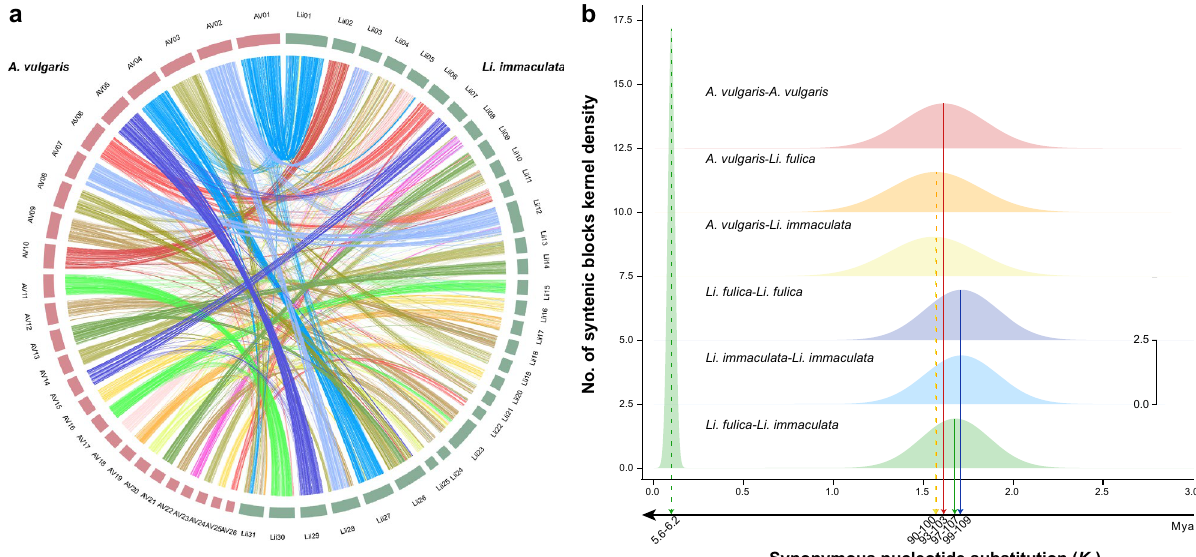
Figure 3. Whole-genome duplication shared by Arion vulgaris , Lissachatina (Achatina) fulica, and Li. immaculata . ( a ) An approximately one to one corresponding relationship in the comparison of A. vulgaris and Li. immaculata genomes. ( b ) Frequency distributions are shown of values of synonymous substitutions ( Ks ) for homologous gene pairs in comparisons of A. vulgaris , Li. fulica and Li. immaculata